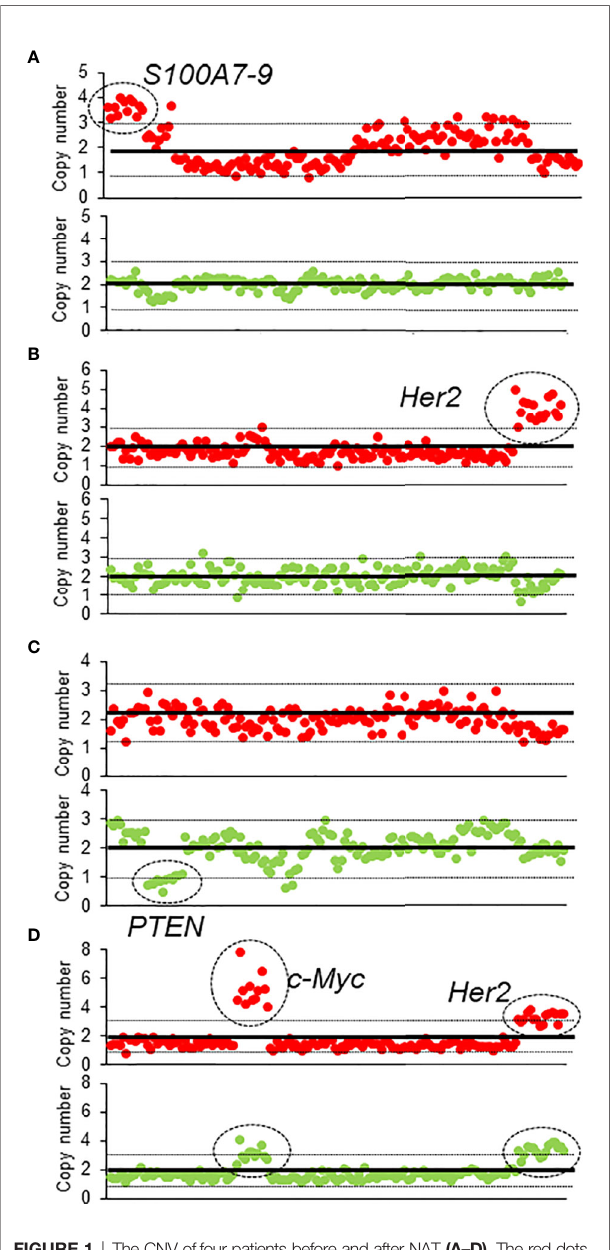
FIGURE 1 | The CNV offour patients before and after NAT (A – D) . The red dots represent the CNV before NAT, and green dots represent the CNV after NAT.